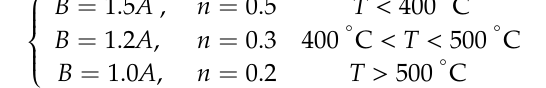
Table 1. Modified JC model parameters for normalized C45E steel.